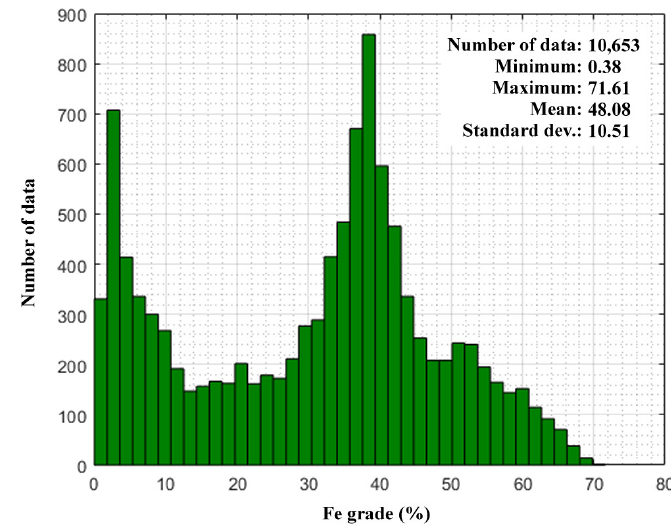
Figure 1. Histogram of composited iron grades.